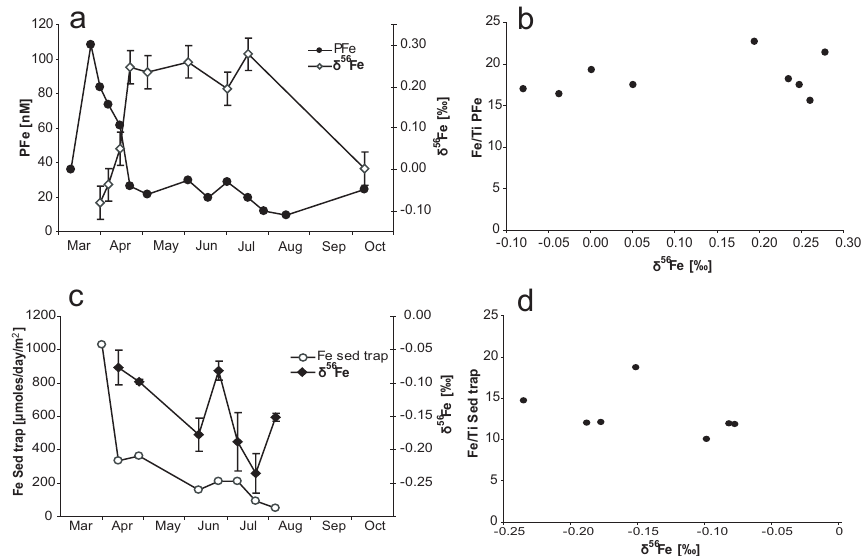
Fig. 11. Isotopic signatures of suspended Fe (PFe) at 5m depth and sediment trap collected material at 30m depth, all data from Landsort Deep 2004. The seasonal variation of δ 56 Fe in PFe a nd the PFe concentration (a) . Error bars indicate instrumental precision ± 2 STD of the mean. δ 56 Fe plotted against Fe/Ti in PFe (b) . Temporal variation of δ 56 Fe in sediment trap collected material and amount of sedimenting Fe (c) . δ 56 Fe plotted against Fe/Ti in the sediment trap collected material (d) .